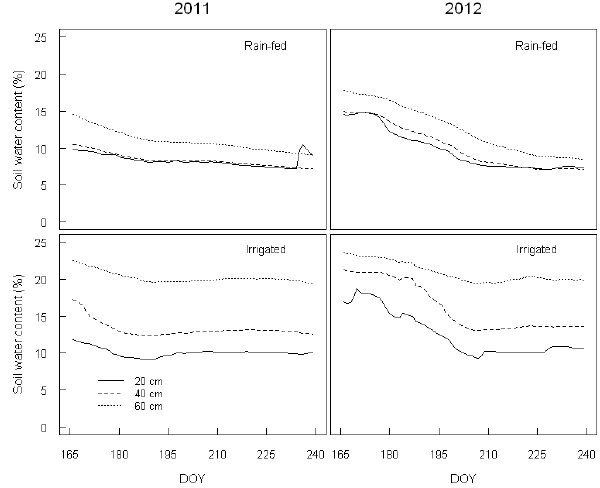
Figure 3. Soil water content at three depths (20, 40, and 60cm) for rain-fed and irrigation treatments over the 2011 and 2012 growing seasons. DOY stands for day of the year (165 = 13